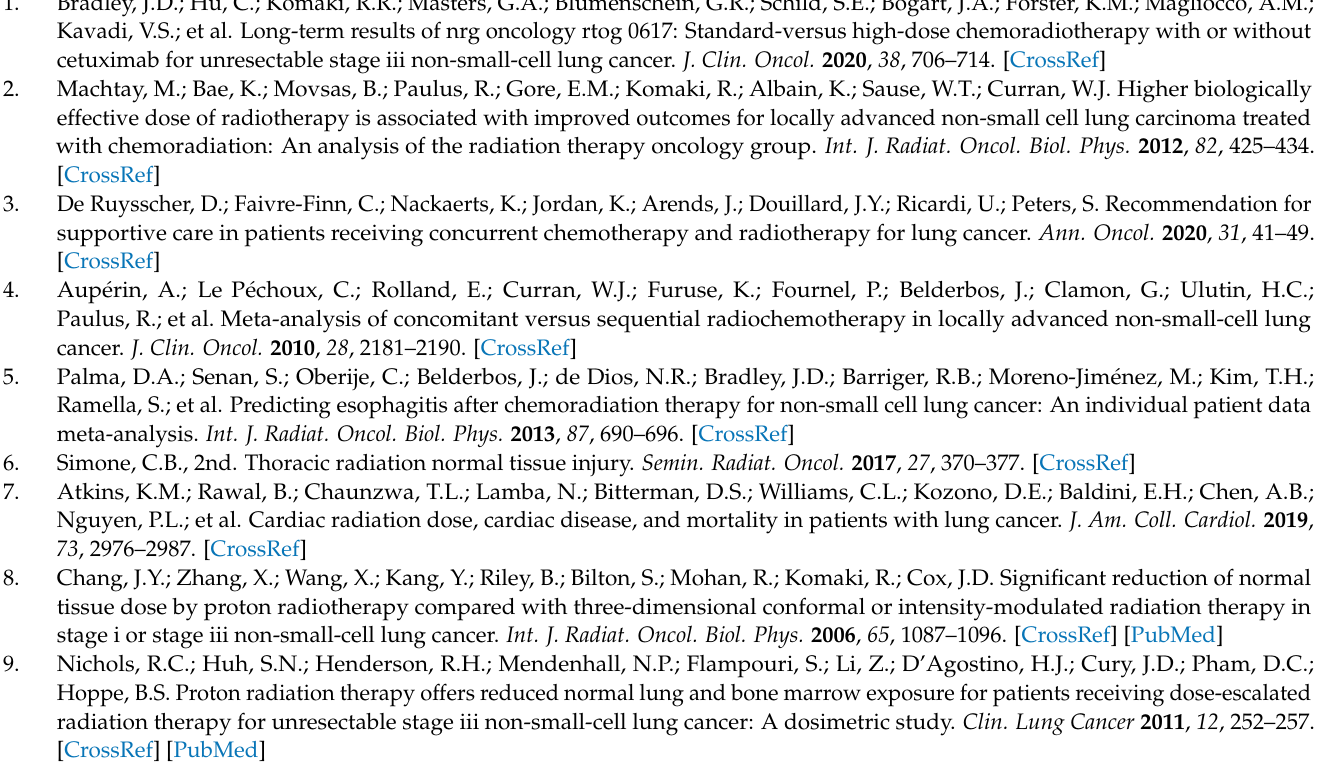
Figure S2: Changes in pulmonary function test after treatment: forced expiratory volume in 1 s (A); diffusing capacity of the lung for carbon monoxide (B), Table S1: Dose volume parameters according to the treatment modality, Table S2: Comparison of target coverage and normal tissue sparing with matched intensity-modulated radiation therapy (IMRT) and intensity-modulated proton therapy (PBSPT)